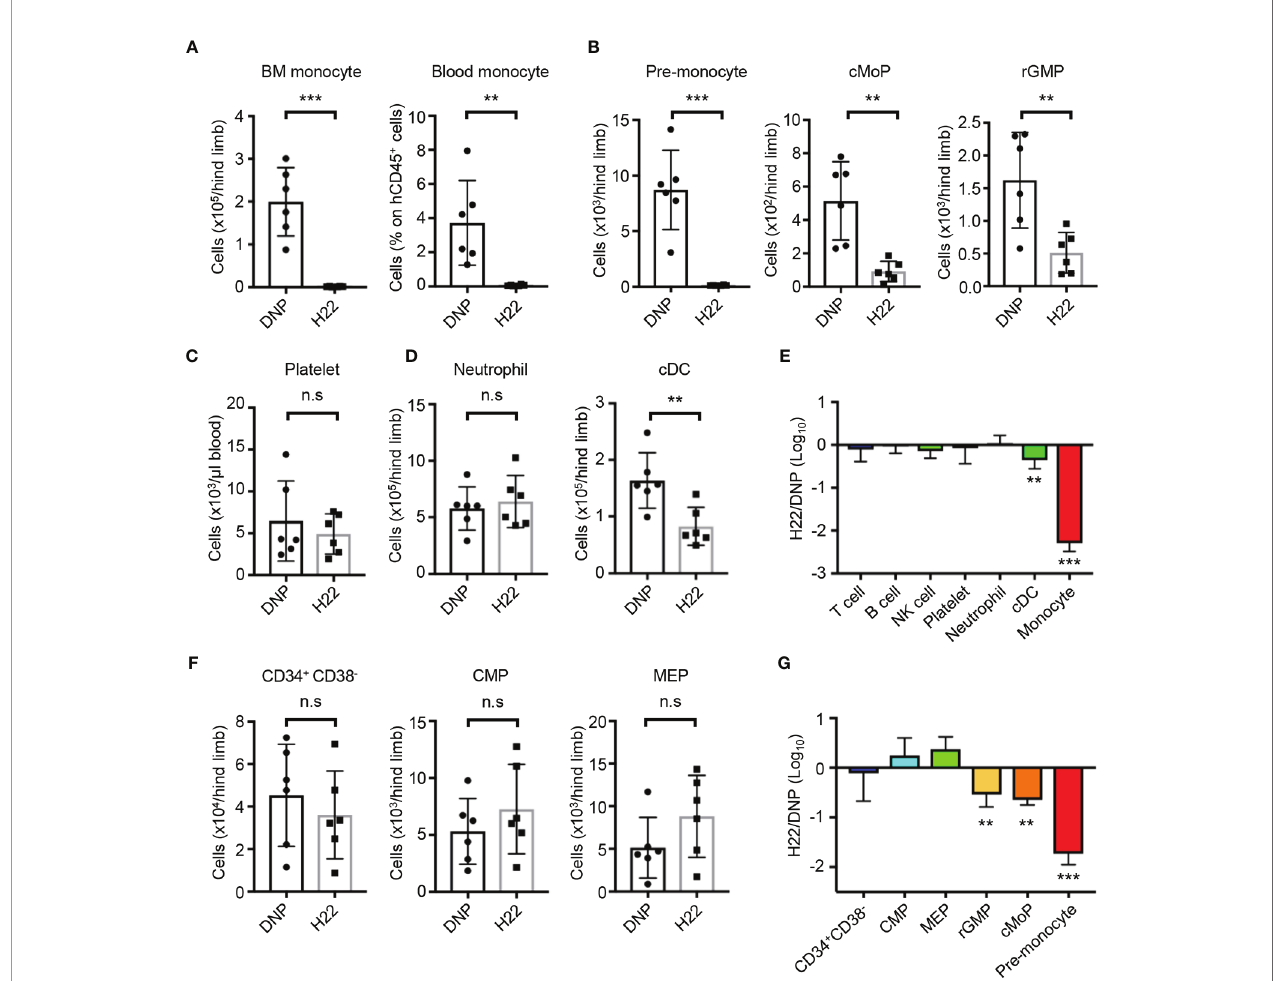
FIGURE 4 | H22-dPBD-mediated elimination of monocytes and their progenitors without severe side effects in hematopoiesis. (A – G) BM-humanized NOG mice were generated as shown schematically in Supplementary Figure 3 . Seven days after intravenous administration of DNP-dPBD or H22-dPBD (0.5 µg/mouse), hematopoietic cells in the BM and blood were analyzed by FCM. The number of BM monocytes and frequency of blood monocytes (A) , cell numbers of monocytic progenitors in the BM (B) , concentration of platelets (TER119 - CD235ab - hCD41a + hCD41b + ) in the blood (C) , numbers of neutrophils and cDCs in the BM (D) , and numbers of Lin - CD34 + CD38 - HSPCs, CMPs, and MEPs in the BM (F) are shown. Ratios in cell numbers of mature immune cells in the BM and results of their statistical analyses between DNP-dPBD- and H22-dPBD-treated mice are summarized in (E) . Ratios in cell numbers of HSPCs and results of their statistical analyses between DNP-dPBD- and H22-dPBD-treated mice are summarized in (G) . Each point in the bar graphs shows the value for an individual mouse (n=6 per group). Error bars represent standard deviation of the mean. Student ’ s t -test (A – D, F) was used to assess statistical signi fi cance. ** p < 0.01, *** p < 0.001; n.s, not signi fi cant. Data were pooled from two (C) or three (A, B, D, F) independent